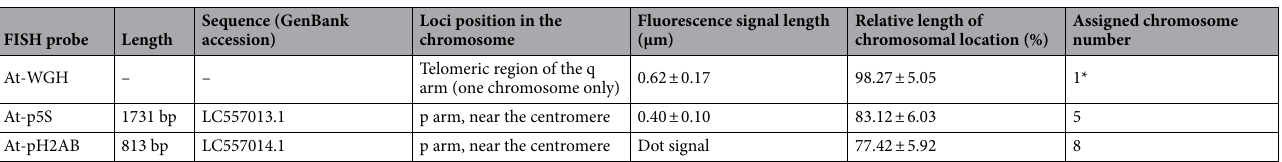
Table 2. Characterization of the fluorescence in situ hybridization probes and their hybridization signals on the chromosomes of Acropora pruinosa . *Only the longer chromosome of the homologous pair.